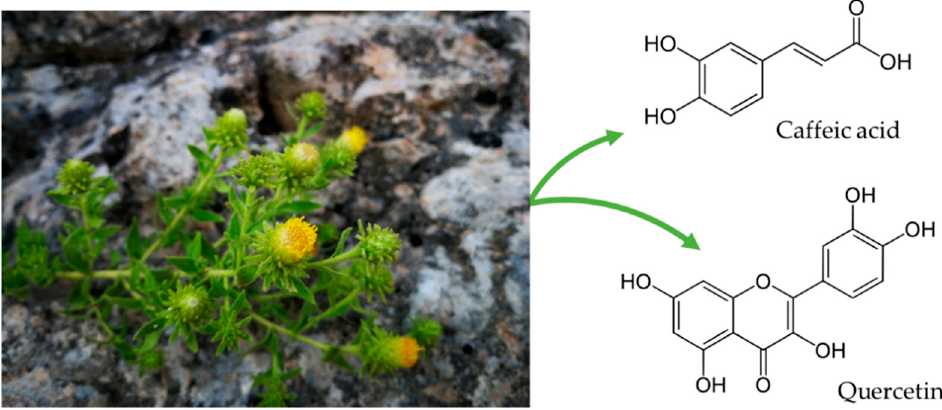
Figure 1. J. glutinosa photography taken by authors and the main phenolic compounds of the extract .